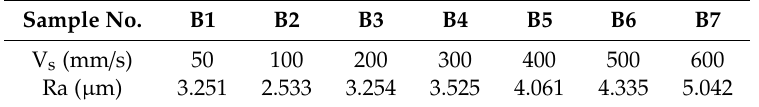
Table 4. The relationship between scanning velocity and the roughness on the cleaned surface. Sample No.